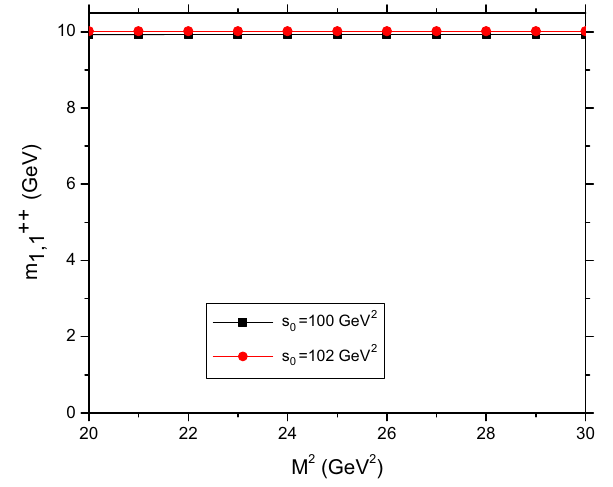
Fig. 11 Borelparameterdependenceof J PC = 1 ++ mesonmassfrom (cid:10) ( 1 ) μναβ for different s 0 values